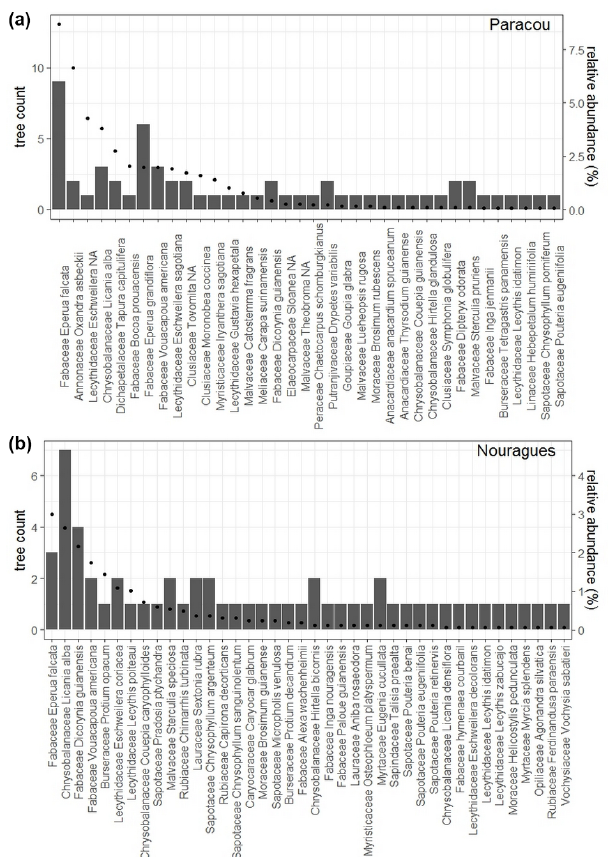
Figure 3. Number of mature trees we sampled per species (bars) and the relative abundance for each species (dots) are shown for (a) Paracou and (b) Nouragues. Relative abundance was calculated as the percent composition of each species relative to the total number of that species with all 50 × 50m plots at Paracou or